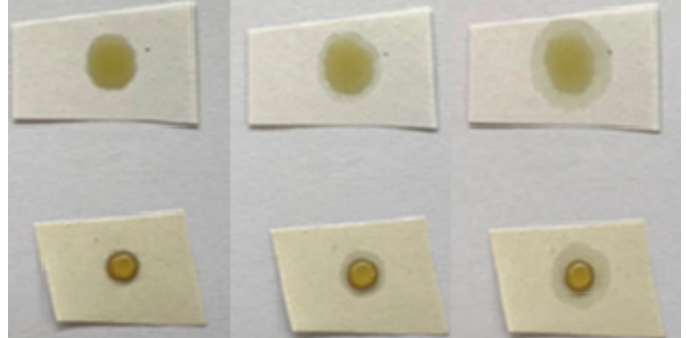
Figure 5. Time lapse of untreated ( above ) and industrial-plasma treated ( below ) paper 2, from left to right, immediately after plasma treatment, 10 min after plasma treatment, and 24 h after plasma treatment.